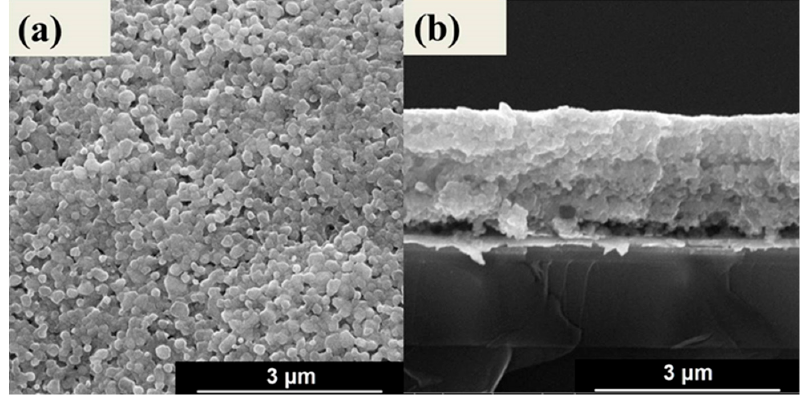
Figure 2. SEM images of the ( a ) surface; and ( b ) cross-sectional morphologies for the 0.82KNN-0.18AN film.